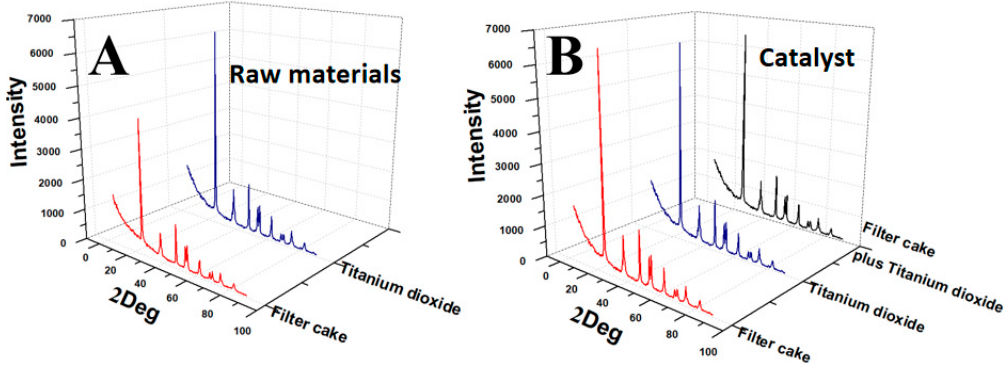
Figure 2. The XRD patterns of the two raw Ti sources ( A ) and the corresponding powdery catalysts produced by different Ti sources ( B ).